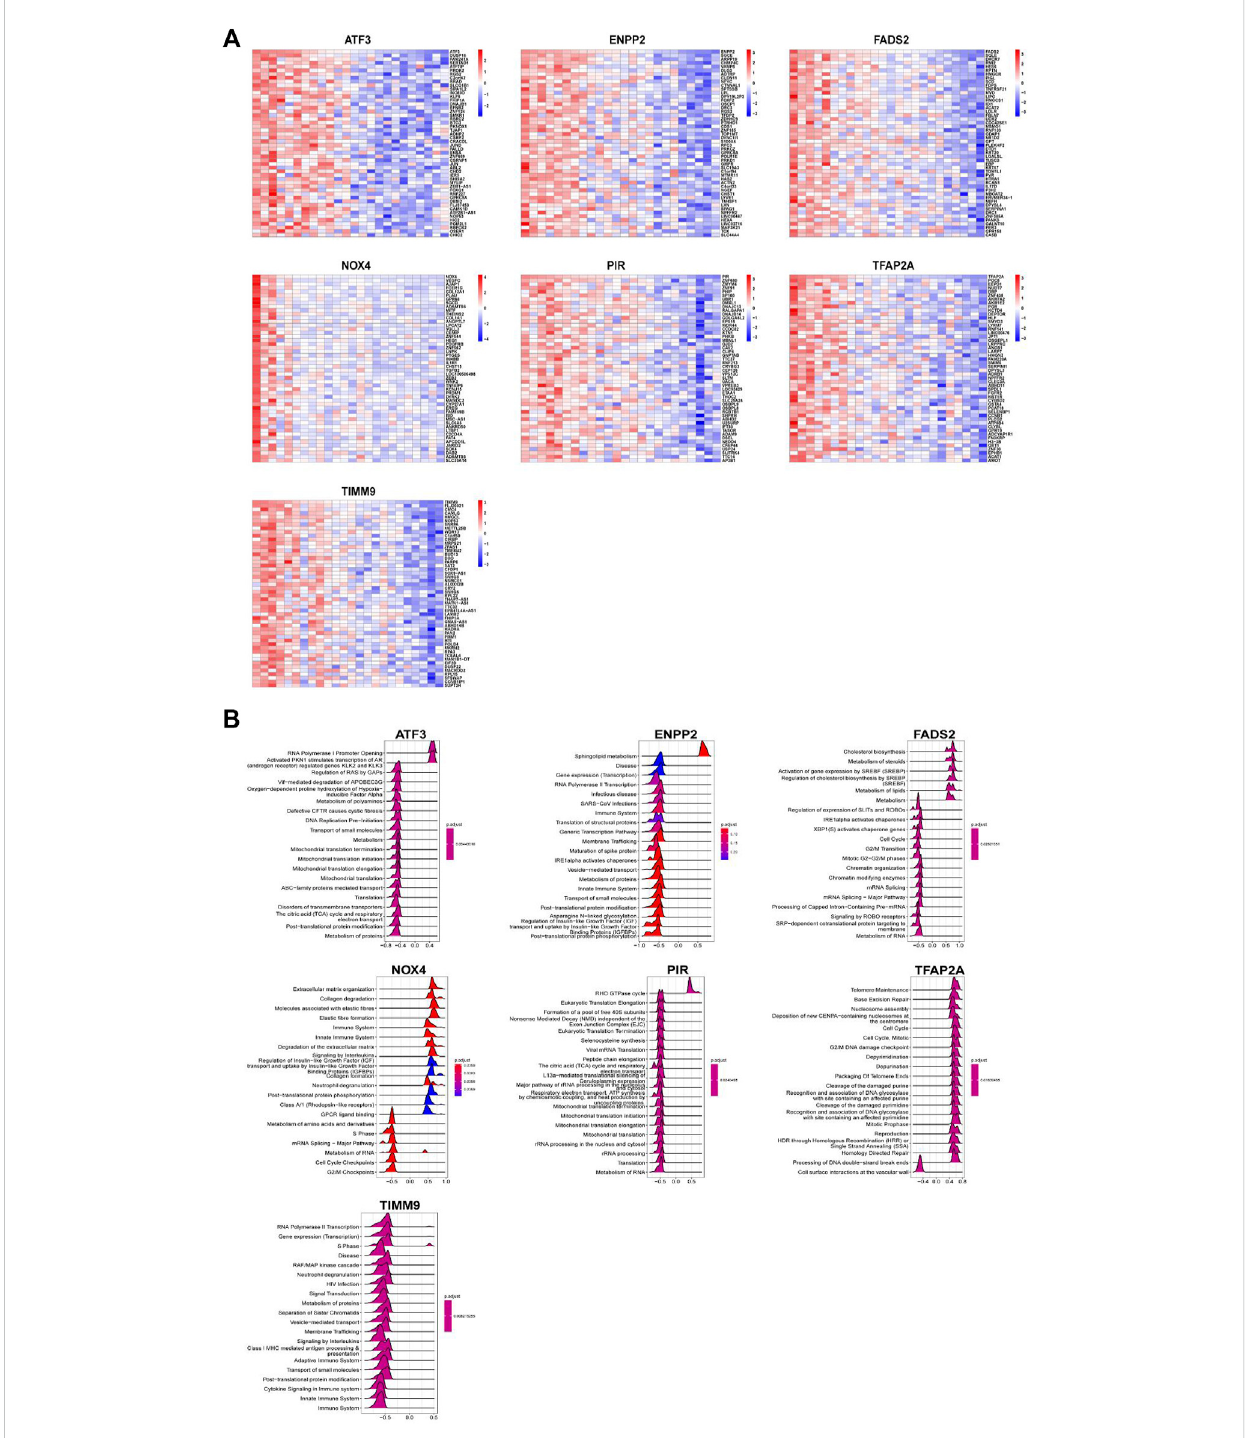
FIGURE 8 Function enrichment analysis of key DEGs. (A) Heatmap display of top50 gene positively related to key DEGs. Function enrichment analysis of key DEGs. (B) Top 20 of GSEA enrichment analysis results of key DEGs.